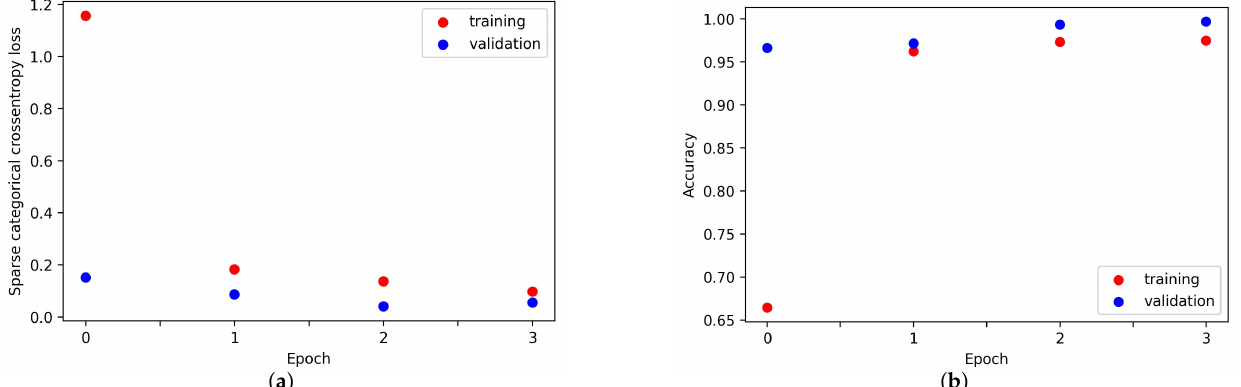
Figure 6. ( a ) Sparse categorical crossentropy loss and ( b ) accuracy for simulated training and validation